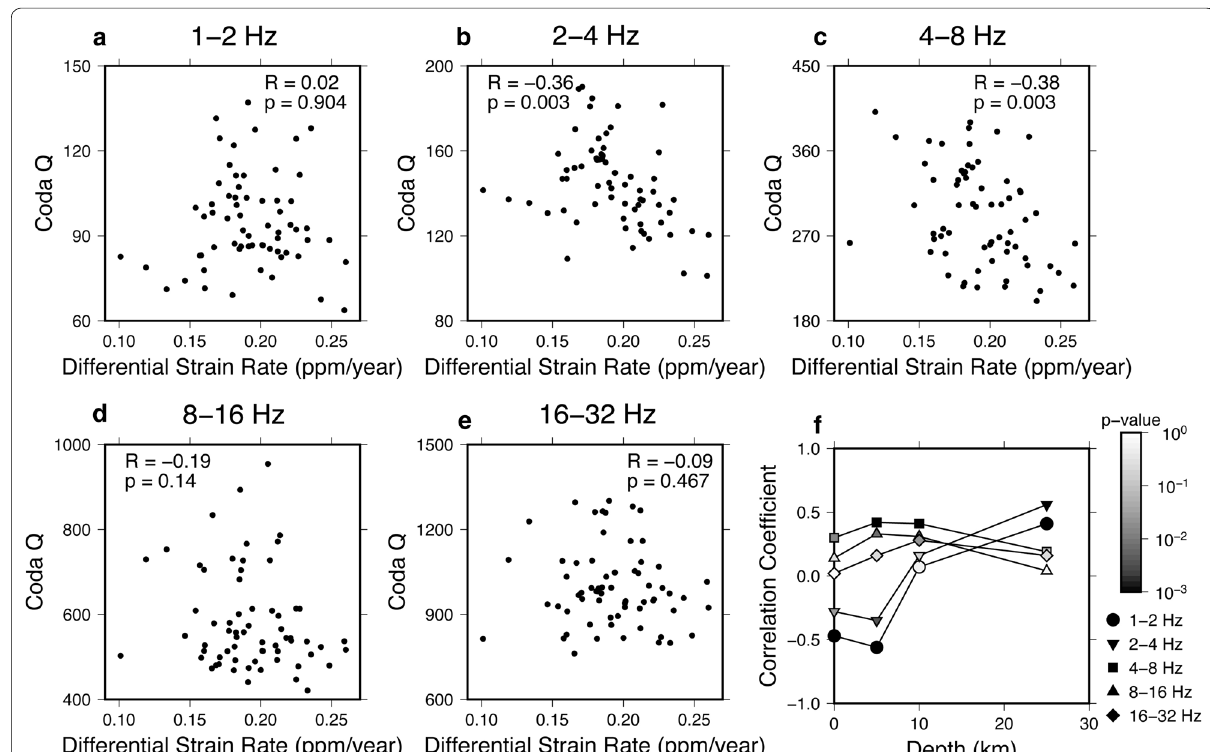
Fig. 4 a – e Plot of differential strain rate versus coda Q at five frequency bands, and f plot of depth versus the correlation coefficient between the coda Q and the S-wave velocity (Nakajima and Hasegawa 2007) in this study area. The gray scale shows the p